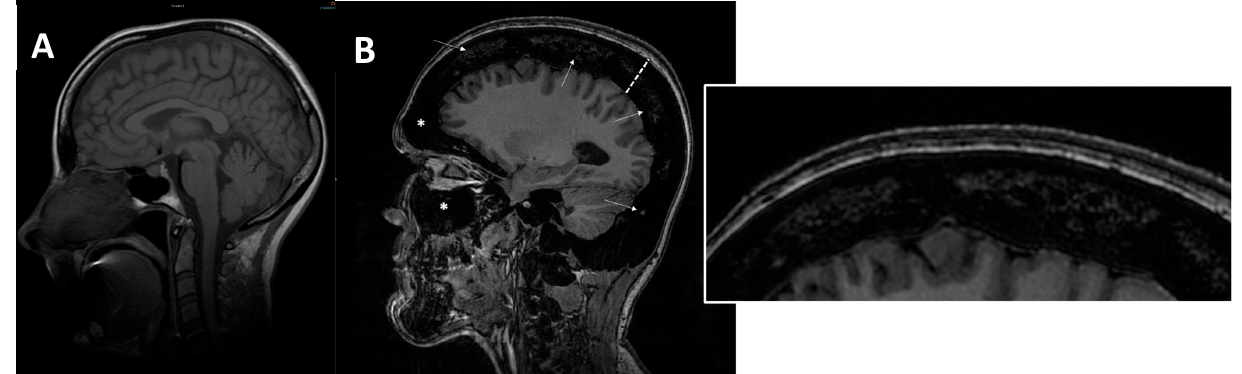
Figure 7. ( A ) axial MRI of a healthy young female (shown as comparison). ( B ) sagittal MRI (proton density sequence) in ARO-type osteopetrosis patient suffering from anaemia (Hb = 7g/dL) shows markedly reduced bone marrow space (arrows and enlargement on the right); diffuse calvarias bone thickening (dotted line), sclerosis (signal hypointensity), and obliteration of maxillary and frontal paranasal sinus (asterisks) can be noted.